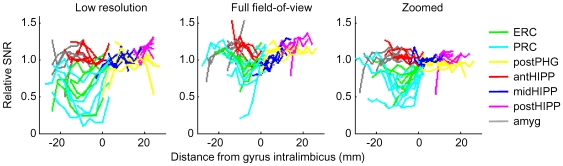
Individual variation of drop-out: zoomed (6 subjects), full FOV (5 subjects), and low resolution EPI (5 subjects).Average signal-to-noise ratio (SNR) in each slice of each ROI, normalized by the average SNR in posterior hippocampus (where no signal loss is present). Slice position is measured from gyrus intralimbicus (G.I.), with negative distances indicating anterior regions. SNR is calculated as mean intensity divided by the standard deviation of 25 timepoints. In anterior PHG, SNR could be either unaffected by intra-voxel dephasing or decreased by as much as 75%, depending on the individual.